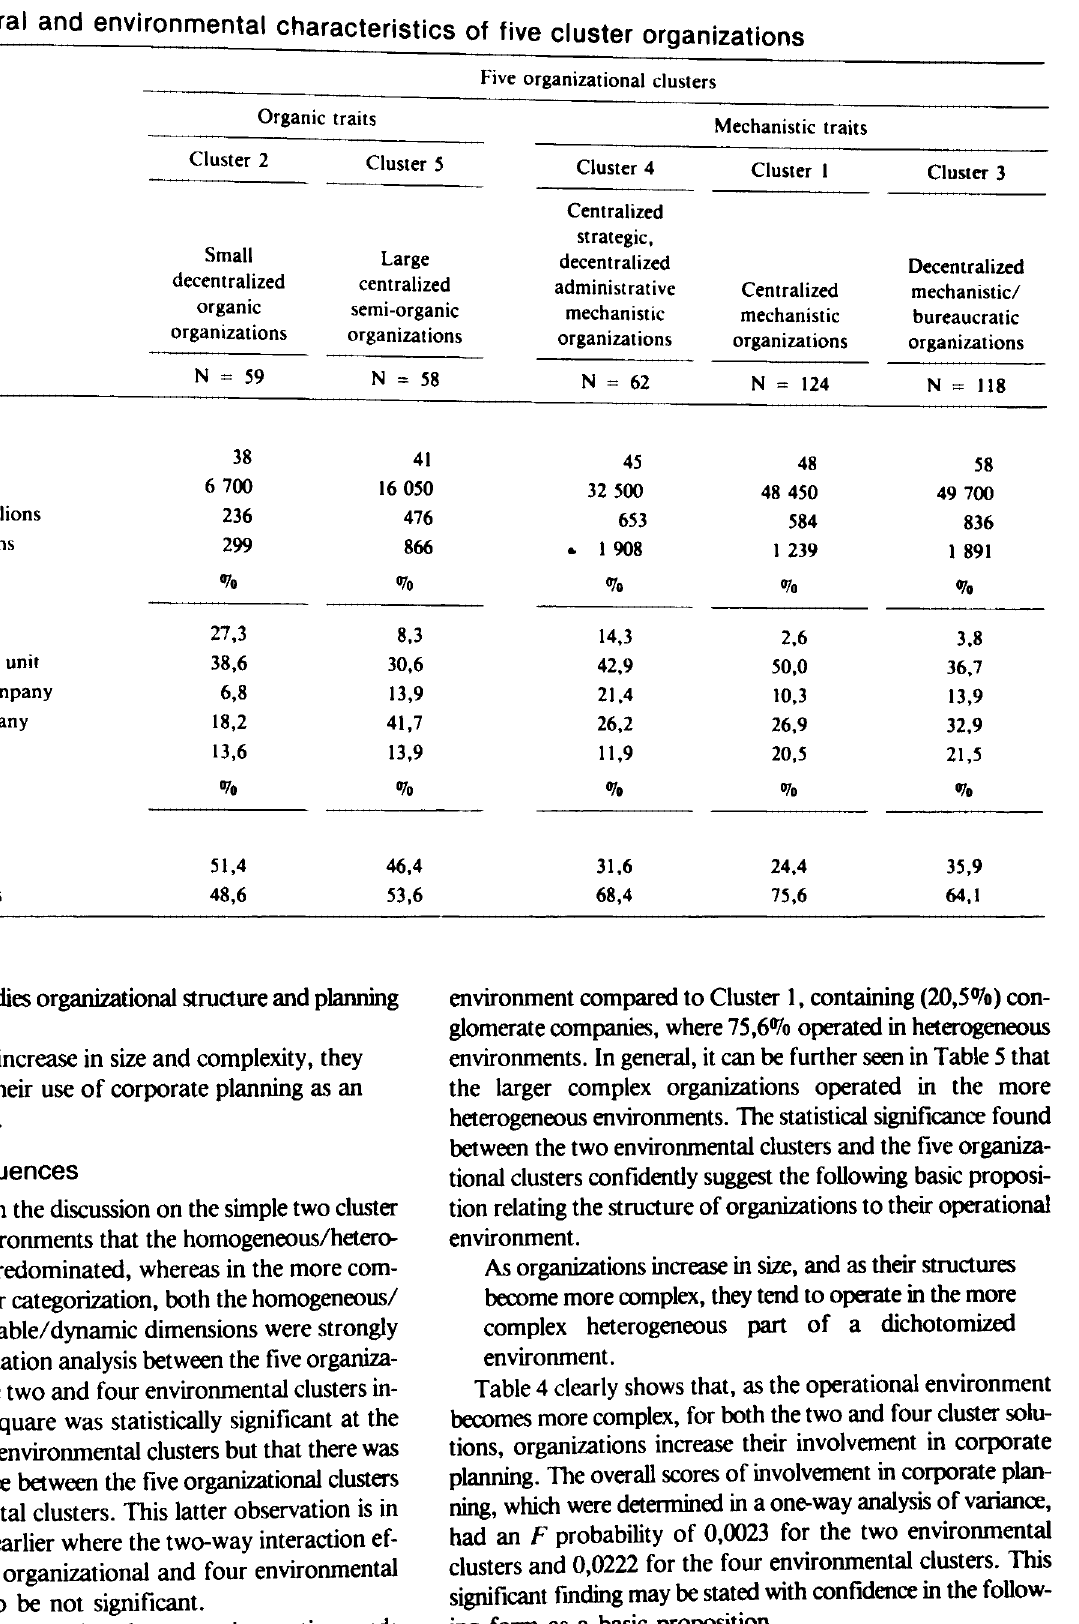
Structural and environmental characteristics of five cluster